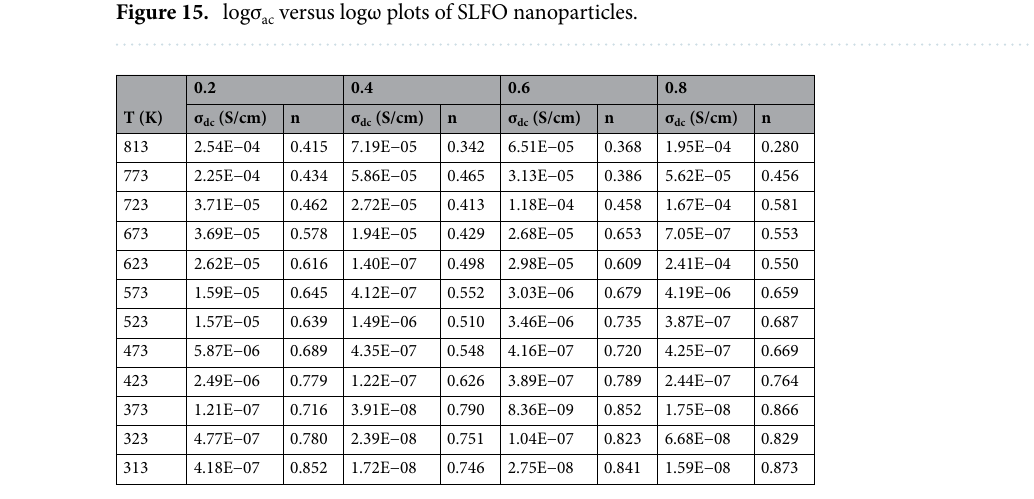
Table 3. DC-electrical conductivity and exponent parameters of SLFO